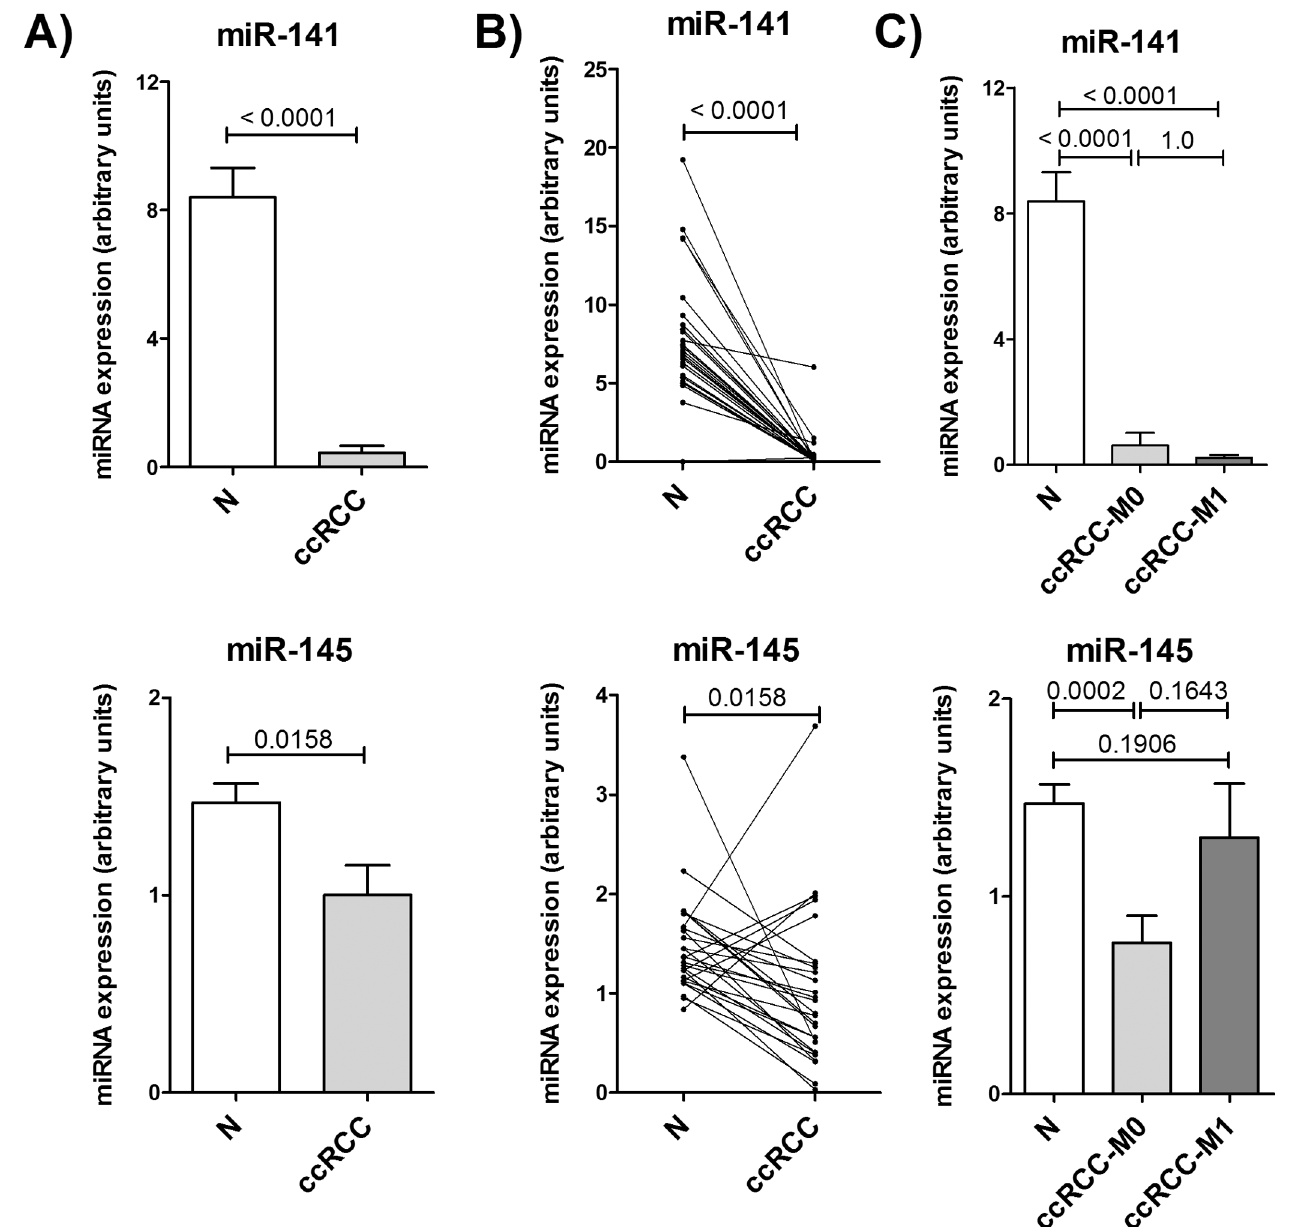
Fig 3. Expression of miR-141-3p and miR-145-5p in ccRCC tissue. Expression of miR-141-3p and miR-145-5p in malignant (ccRCC) and non-malignant (N) renal tissue of 27 ccRCC patients was measured by RT-qPCR. A) and B) show expression differences between paired normal and ccRCC samples. In C) ccRCC tumors are split into non-metastatic (ccRCC-M0; n = 15) and metastatic tumors (ccRCC-M1, n = 12). P-values are given as numbers above bars. Paired samples: Wilcoxon test; unpaired samples: Mann-Whitney test.